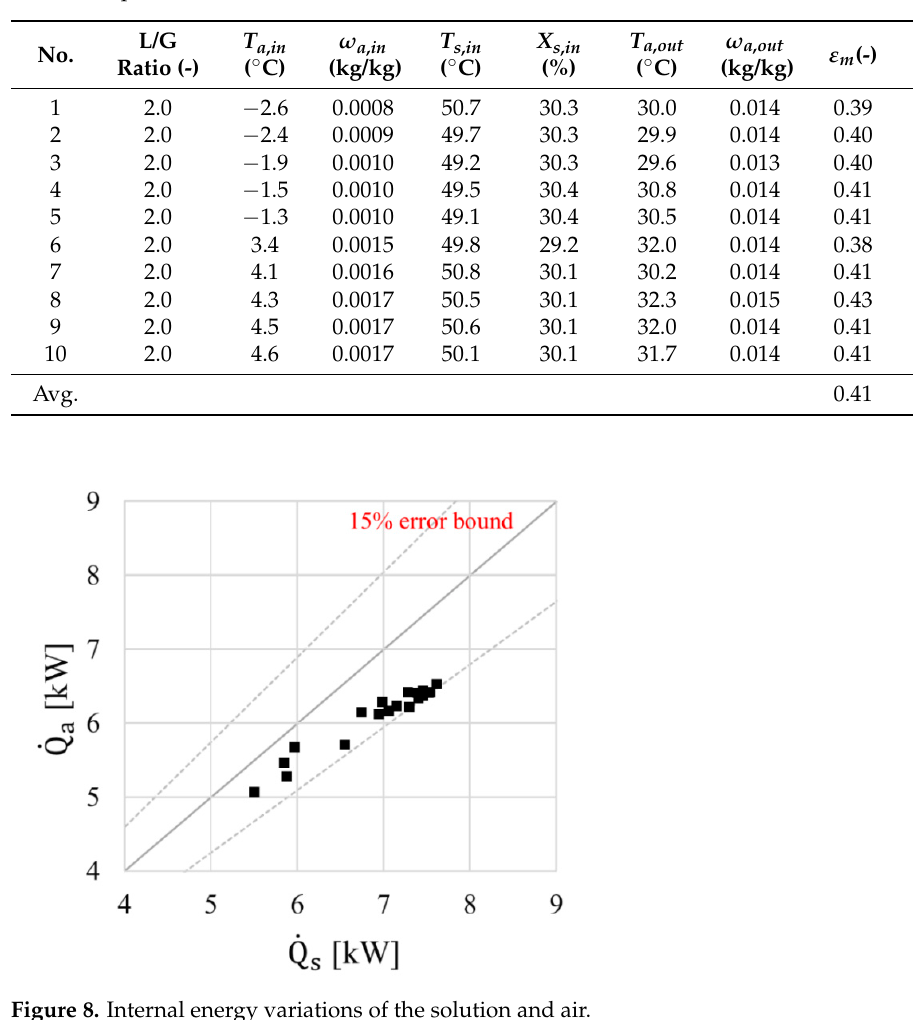
Figure 7. Humidification and enthalpy effectiveness data according to OA conditions. Table 5. Experimental results for REG in humidification mode.